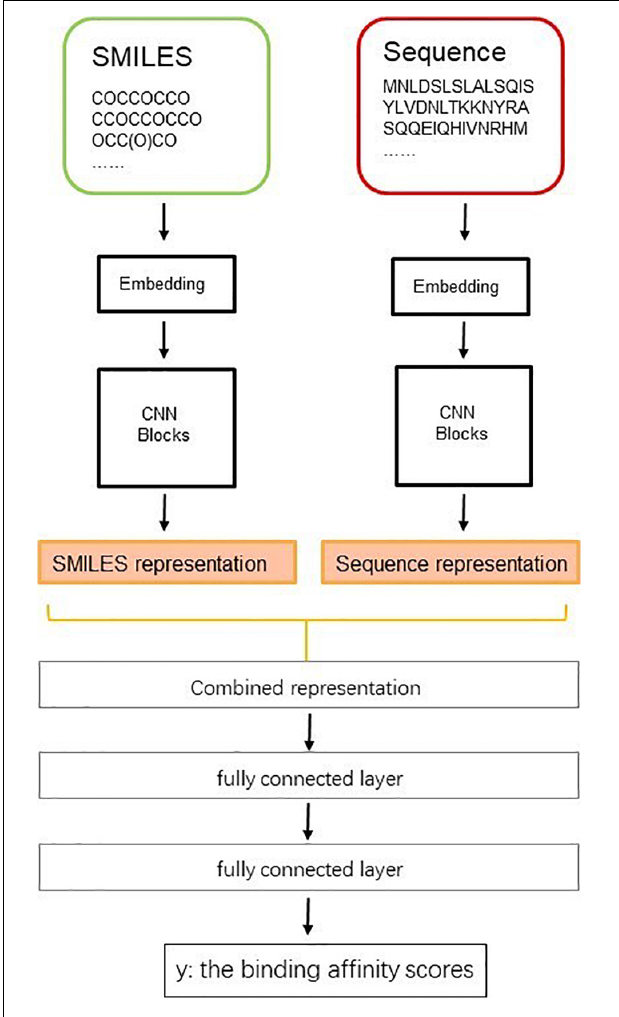
FIGURE 13 | Diagram of deep learning model to predict the binding affinity scores of